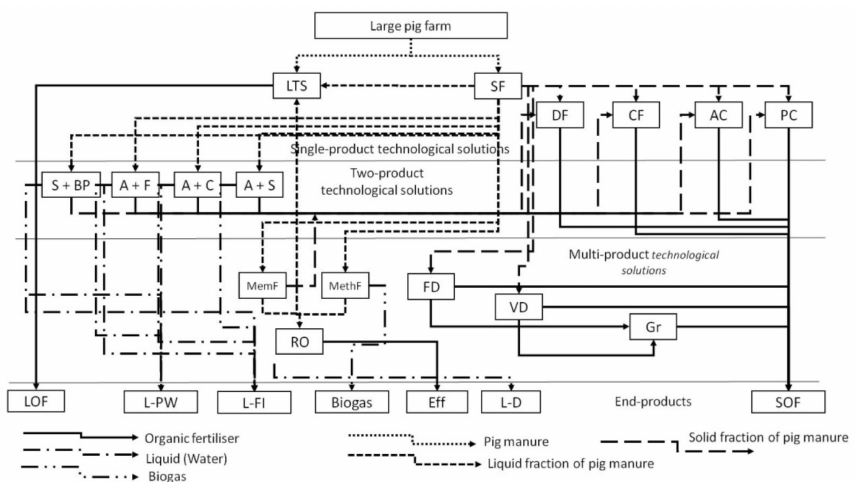
Figure 5. General procedure of designing the technologies to obtain the end-products from pig